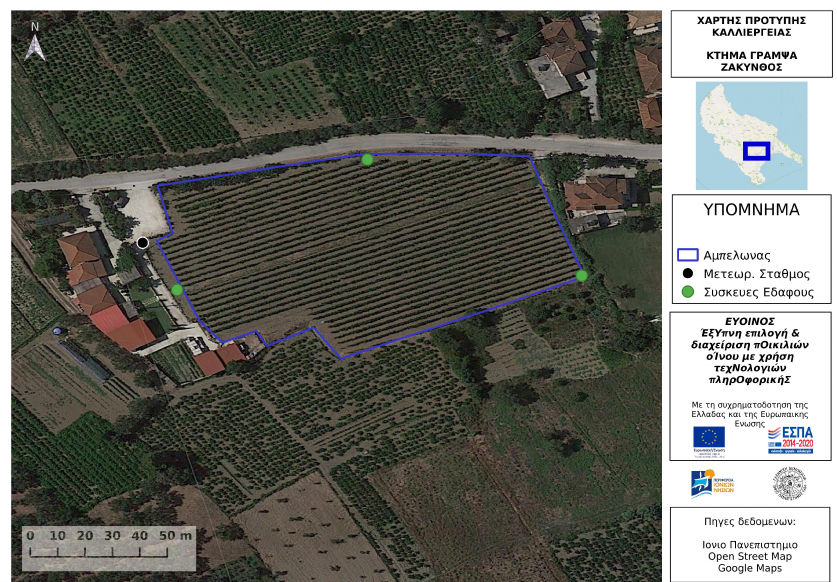
Figure 9. Map of Klima Grampsa installation.